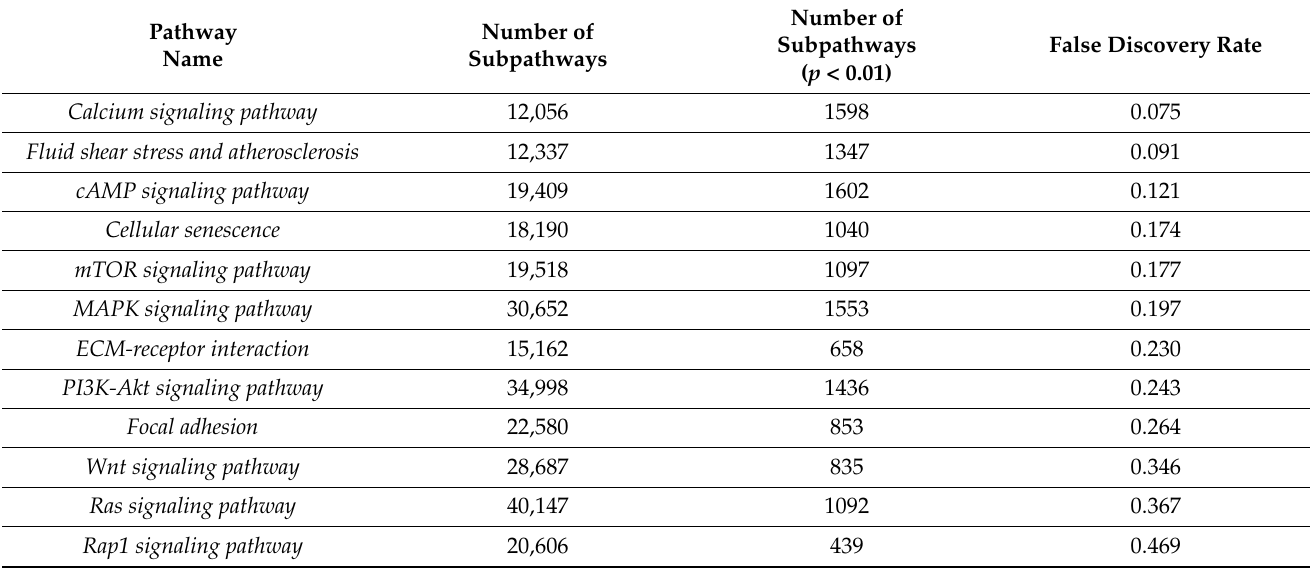
Table 6. Significantly upregulated subpathways in drug-resistant samples of triple-negative breast